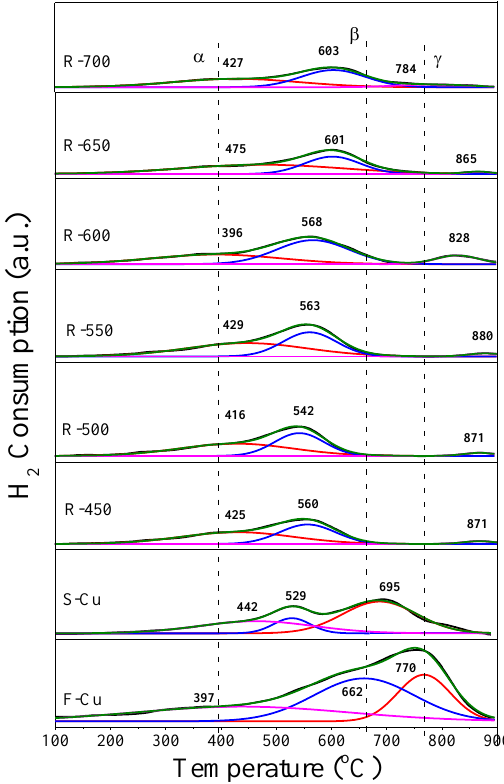
Figure 6 . Temperature programmed reduction (TPR) profiles of Cu-SSZ-13 catalysts in fresh, sulfated and regenerated states.